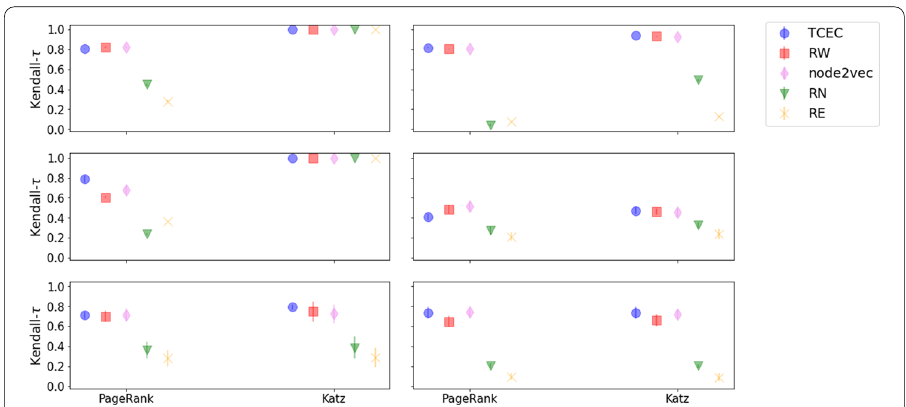
Fig. 11 Results on approximation of spectral centrality measures, PageRanks and Katz, for different dataset. In order from top to bottom and from left to right Epinions, Slashdot, Stanford.edu, Adolescent Health, Caenorhabditis elegans and US Power Grid. Scatterplots represent average results over 10 runs on the three datasets, with standard deviation indicated by vertical